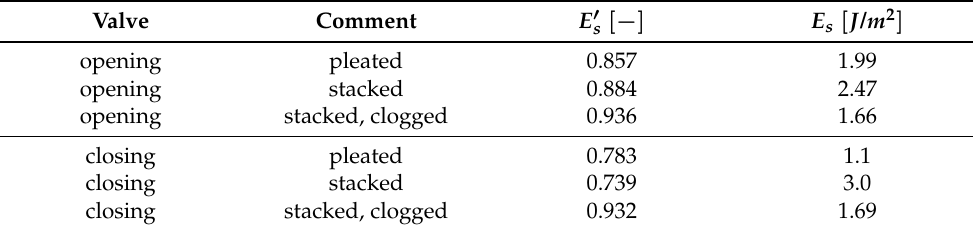
Table 3. Dimensional ( E s ) and non-dimensional ( E (cid:48) s ) specific energy intake for all experimental cases. The dimensional specific energy intake was calculated using time resolution of 20 µ s and moving window size of measurements. ∆ p = 0.5 bar in all cases.